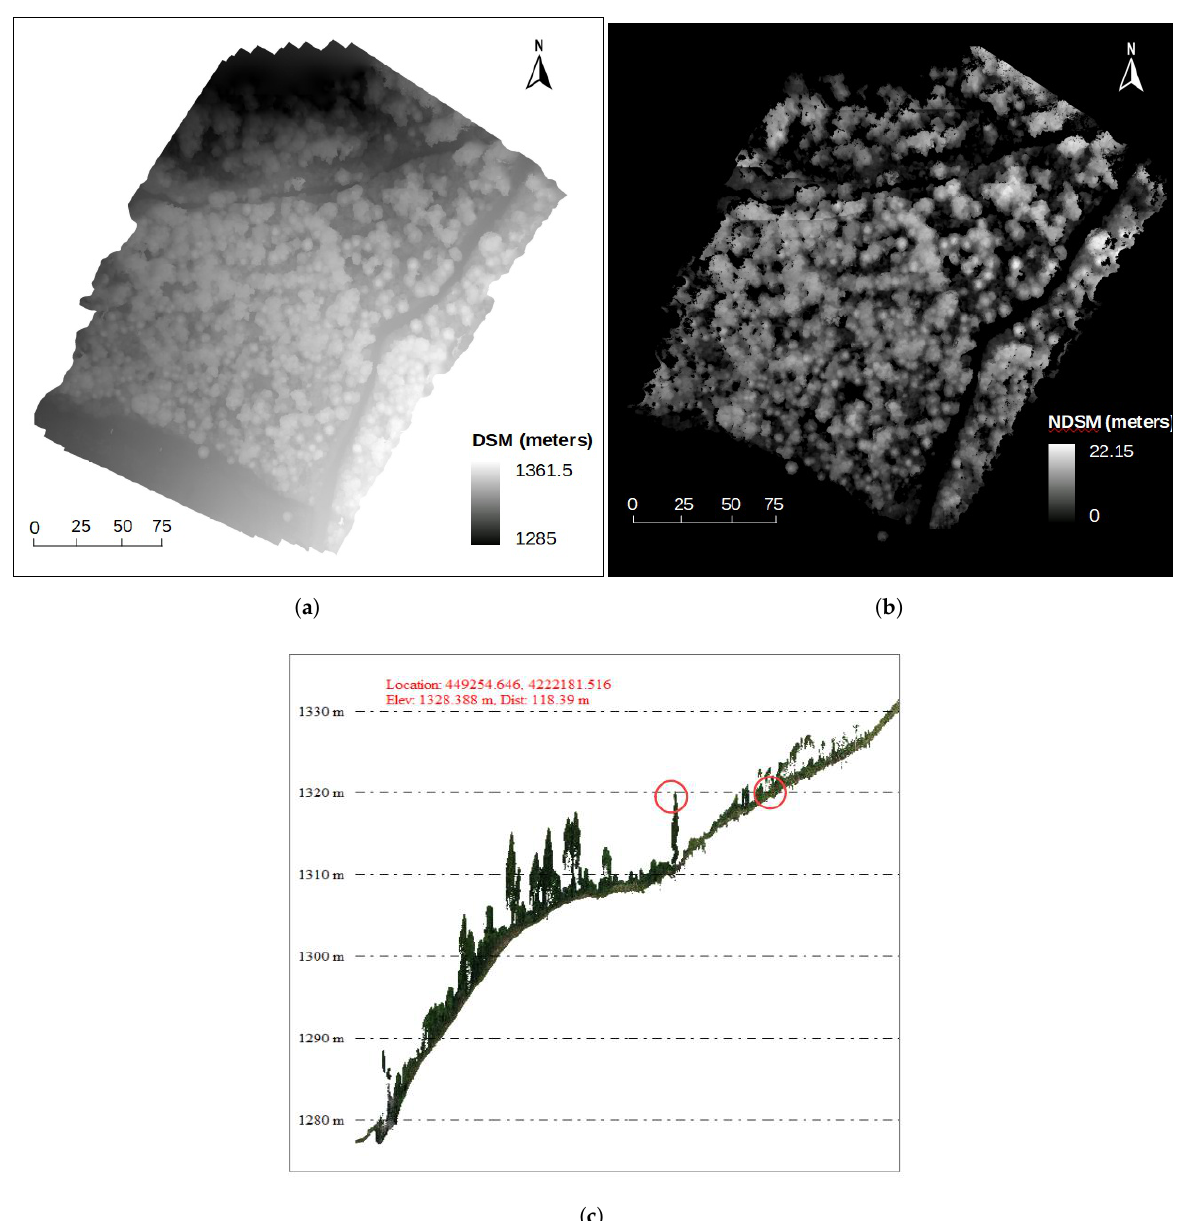
Figure 4. ( a ) DSM and ( b ) nDSM, the lighter (white) pixels represent high elevations and darker pixels represent low elevations, the black pixel on nDSM represents no value or the excluded ground and lower vegetation area; ( c ) the elevation profile of a random area on the DSM at an altitude of 1320 m as a treetop downhill is at the same altitude of the ground uphill (red